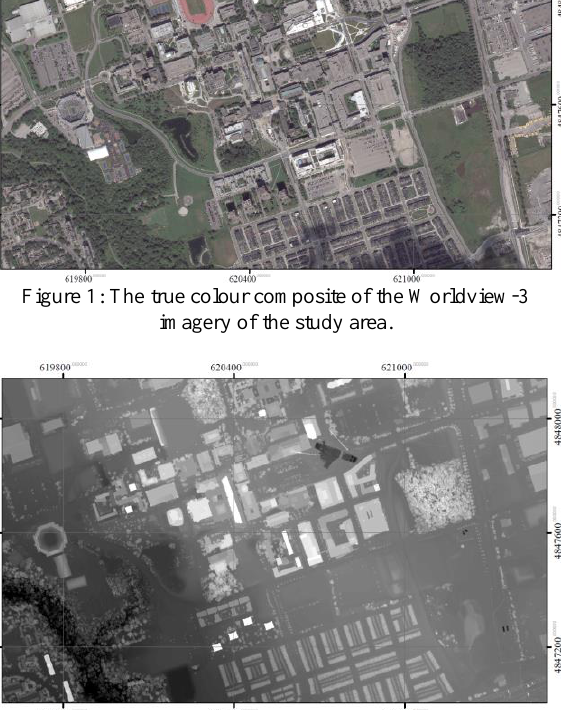
Figure 2: The digital surface model (DSM) derived from the airborne LiDAR data over the study area. The lowest elevation (dark) is 170.80 meters, while the highest one (bright) is 255.88